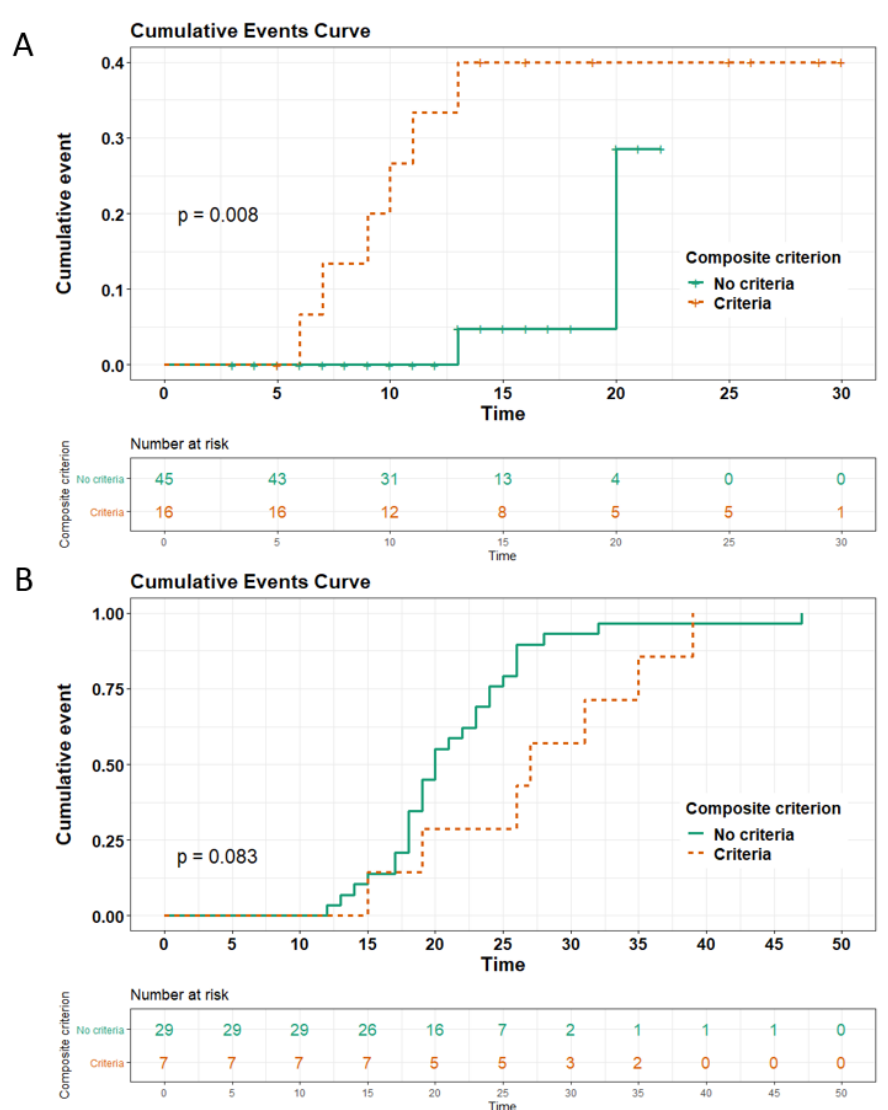
Figure 2. Cumulative events curve of ICU transfer or death in panel ( A ) and time to hospitalization discharge in panel ( B ), depending on the presence of double criteria D-dimers ≥ 2000 ng/mL and neutrophils count ≥ 7 G/L (composite outcome). The p represents the global p -value of Log-rank test in the Cox model. The risk table represents the patients still at risk of the